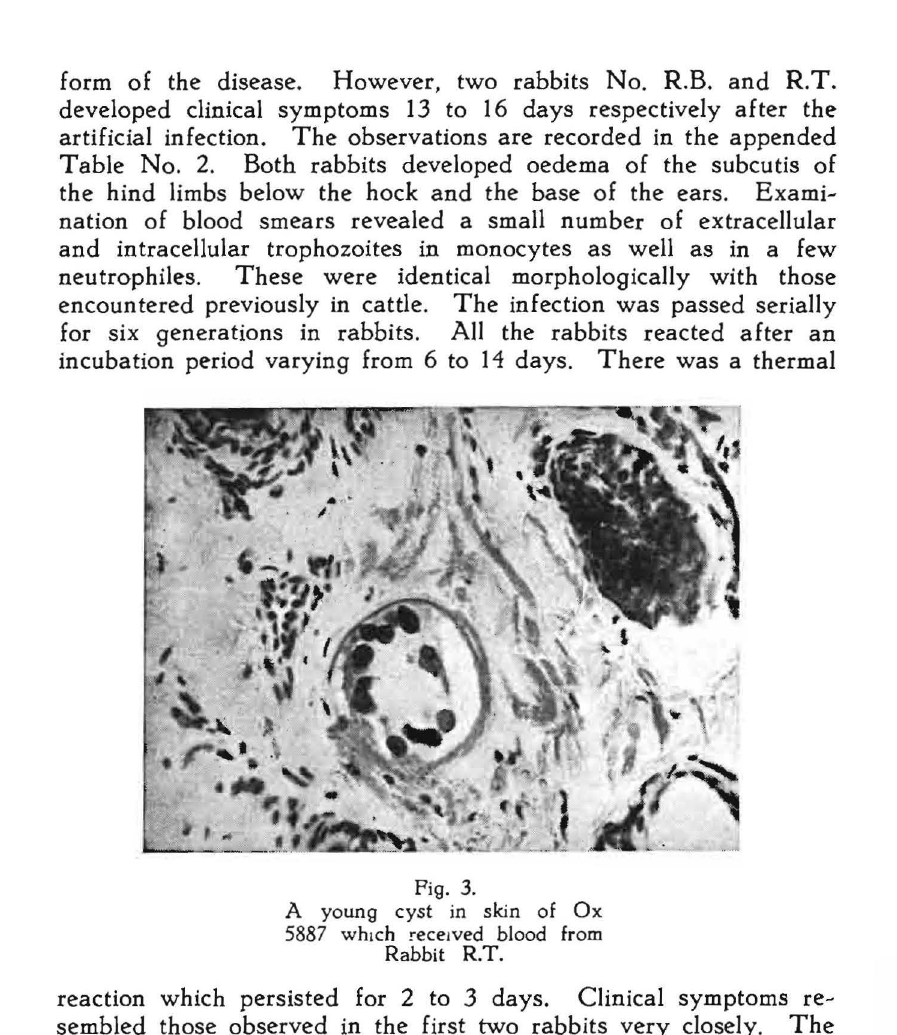
Fig. 3. A young cyst in skin of